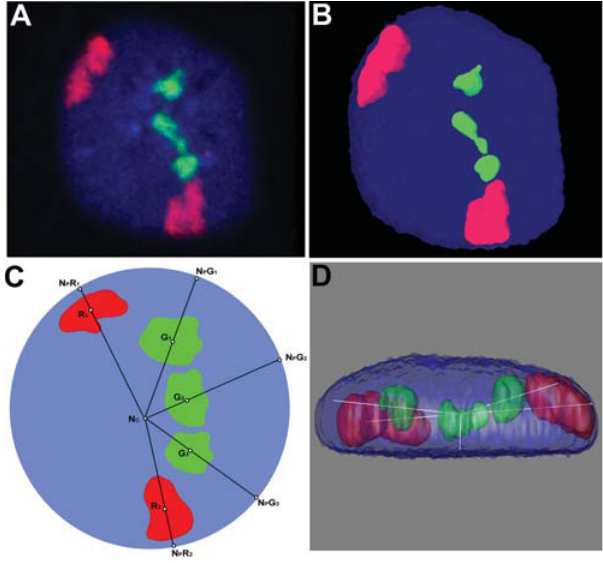
Figure 3. A: Maximum intensity projection of a representative confocal image stack with Chromosome territories 7 (Red, Spectrum orange) and 19 (Green, Rhodamine Green) from DLD-1 + 19 B: A 3D reconstruction of the nucleus and chromosome territories from the image shown in A (X- Y orientation). C: A scheme adopted for 3D distance measurements of chromosome territories in Red (R 1 and R 2 ) and Green (G 1 , G 2 , and G 3 ) from the geometric center of the nucleus (N c ), to the nuclear periphery (N P ). Points on the nuclear periphery (eg. N p R 1 ) are extensions from the nuclear center through the geometric center of the chromosome territory. D: 3D reconstruction in B shown in X-Z orientation.